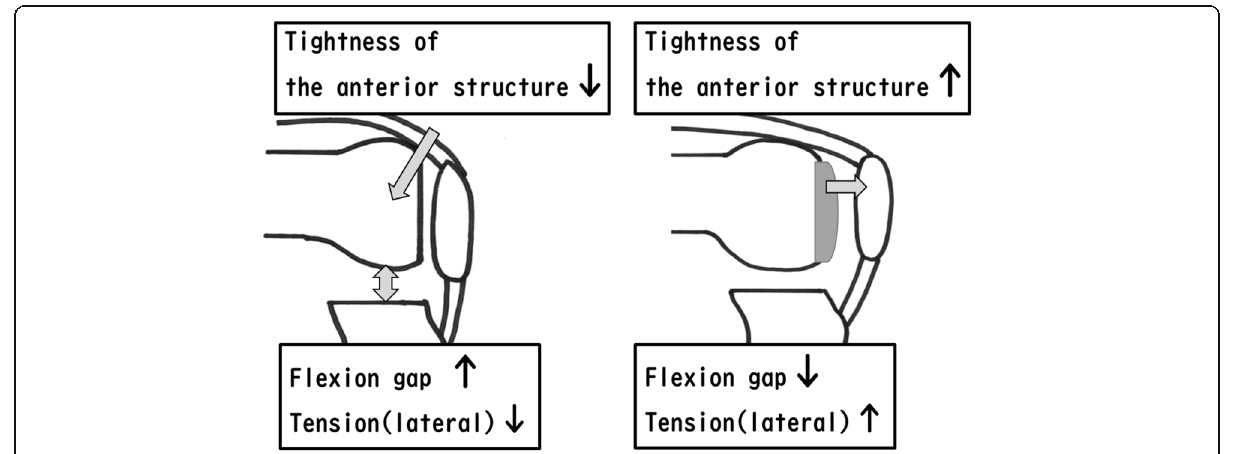
Fig. 1 Distal femoral trial